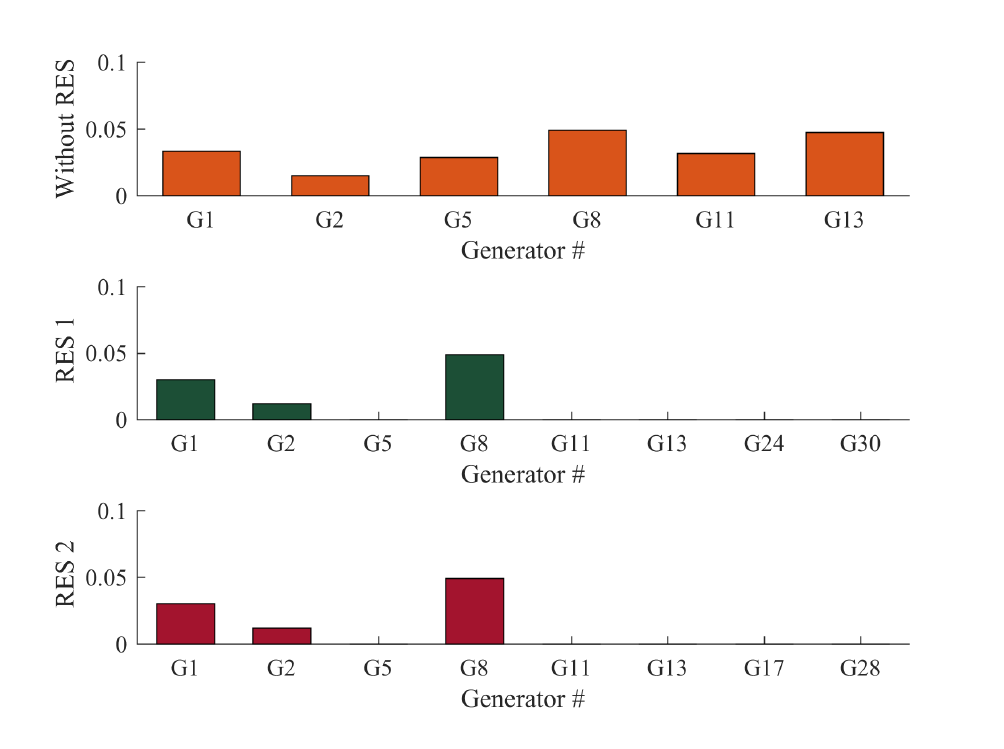
Figure 7. Emission index (ton/hr) for case 2 IEEE 30-bus system, IEEE 30-bus Modified (1) and IEEE 30-bus Modified (2).